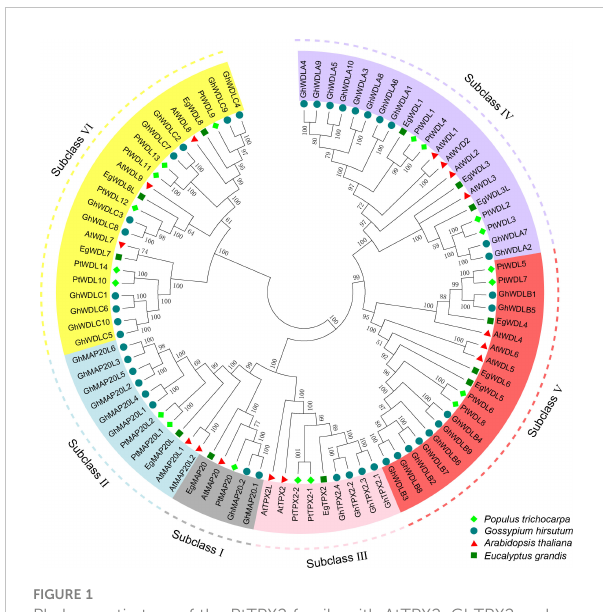
FIGURE 1 Phylogenetic tree of the PtTPX2 family with AtTPX2, GhTPX2 and EgTPX2 as internal reference. All the proteins were divided into six subclasses (I-VI), with PtTPX2 family members highlighted by bright green diamonds and other species distinguished by different colors and shapes.